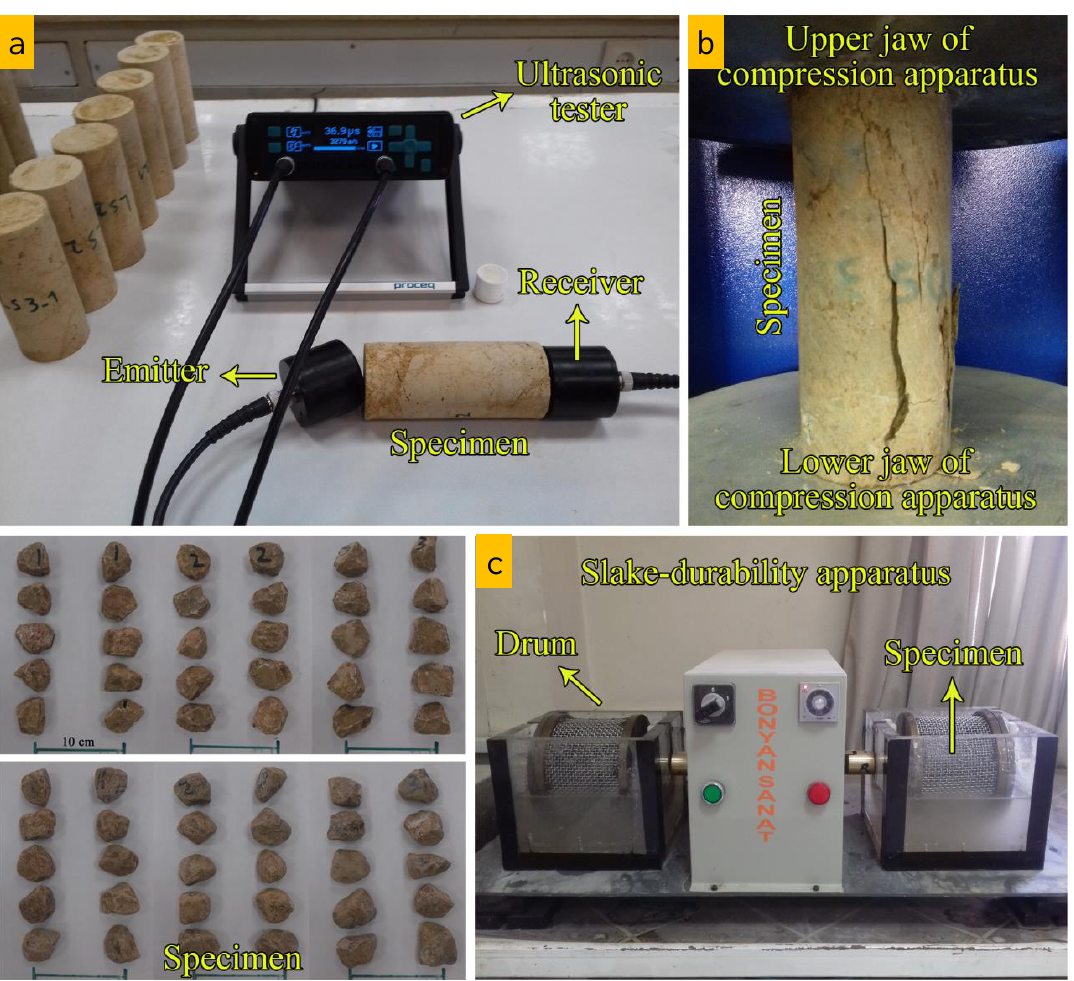
Figure 4. Testing procedure and the used apparatuses for the study. ( a ) P-wave velocity test, ( b ) uniaxial compressive test, and ( c ) slake durability test.